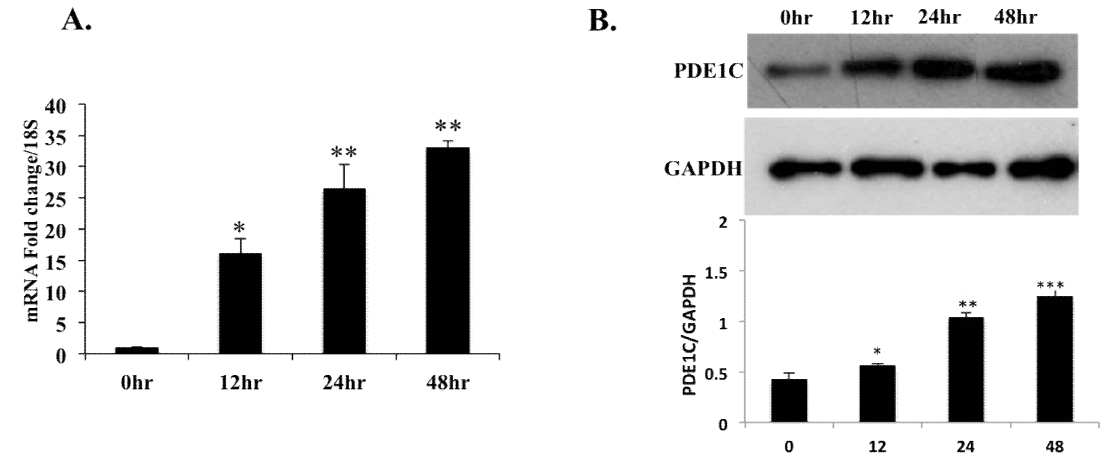
Figure 1. PPARα agonist Wy-14,643 treatment increased Pde1C mRNA and PDE1C protein expression in H9c2 cardiomyocytes: H9c2 cardiomyocytes were treated with 100 μM Wy-14,643 for 12-, 24-, and 48-h. Total RNA and total protein from cells were used for RT-qPCR and Western blot analysis, respectively. ( A ) Pde1C mRNA levels in Wy-14,643-treated H9c2 cardiomyocytes increased by 16-, 26-, and 33-fold at 12-, 24-, and 48-h, respectively. ( B ) Total protein extracts from H9c2 cells treated with Wy-14,643 for 12-, 24-, and 48-h was analyzed by Western blot using anti-PDE1C antibody, GAPDH was used as loading control. PDE1C protein bands were quantified (lower panel) as described in Section 4 and normalized to GAPDH. PDE1C protein levels increased upon Wy-14,643 treatment. Data was analyzed by t -test, n = 4–6 per group, * p < 0.05, ** p < 0.01, *** p < 0.001.